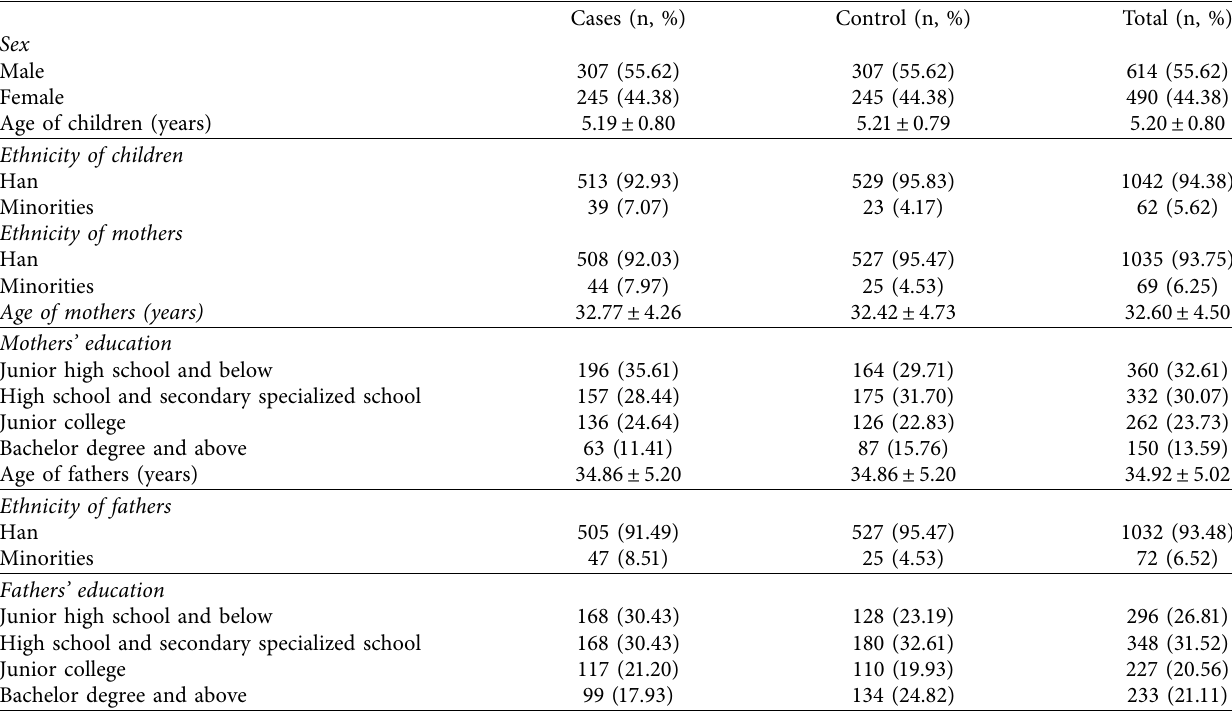
Table 1: Baseline characteristics of